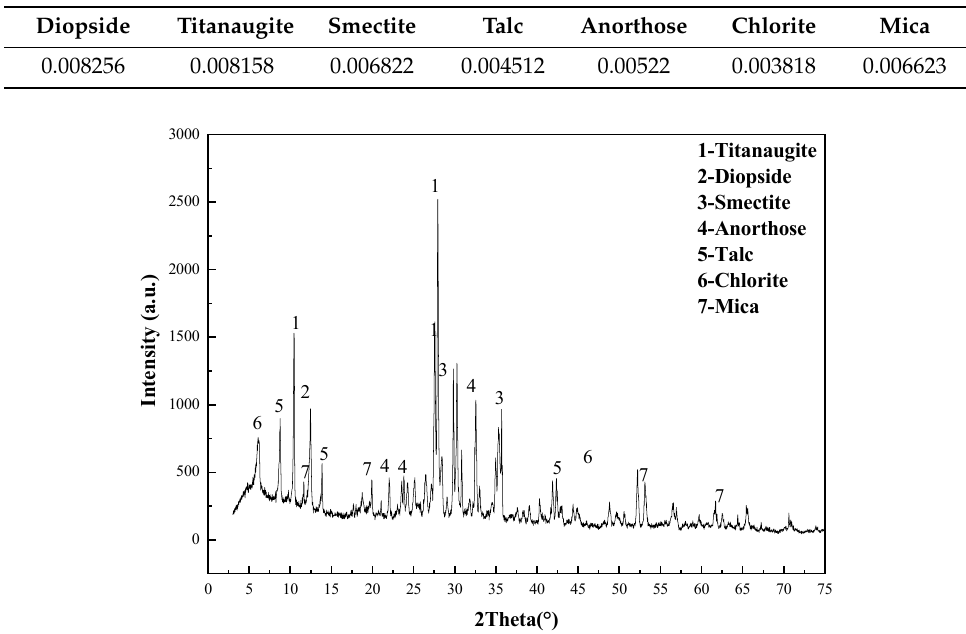
Figure 1. X-ray di ff raction (XRD) di ff ractogram of scandium rough Figure 1. X-ray diffraction ( XRD) diffractogram of scandium rough concentrate.